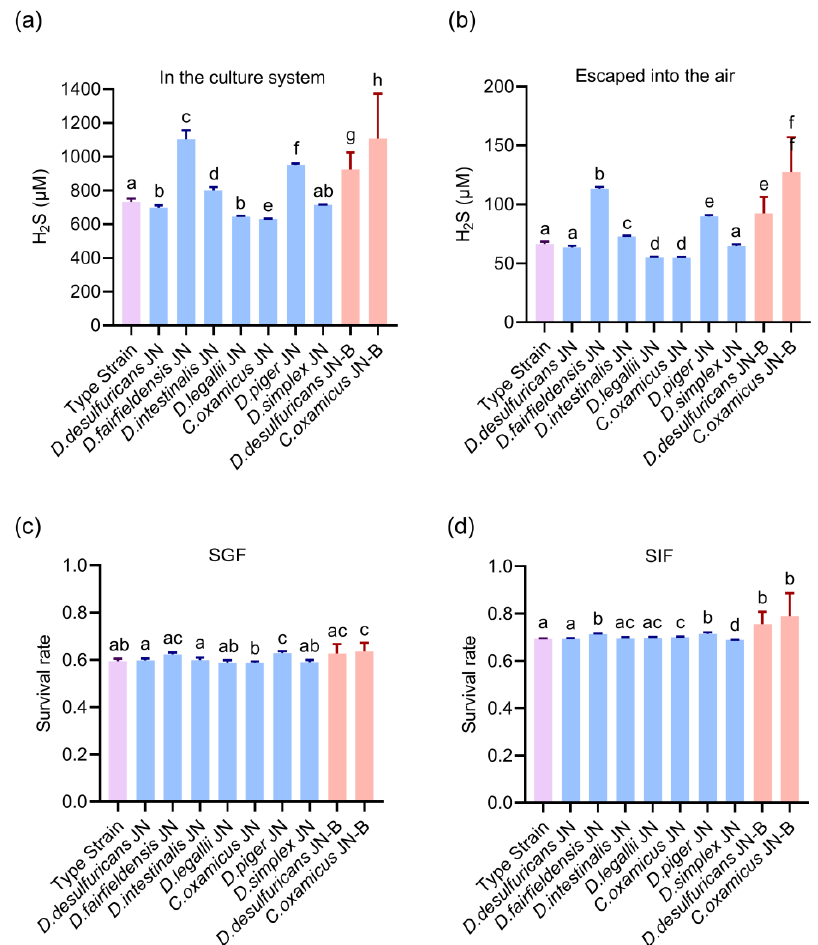
Figure 4. Hydrogen sulfide production and gastrointestinal tolerance of Desulfovibrio from the human gut. ( a , b ) The hydrogen sulfide production of isolates ( a ) in the culture system and ( b ) escaped into the air after 4 days of culture. ( c , d ) Evaluation of intestinal colonization of Desulfovibrio in ( c ) SGF (simulated gastric fluid) and ( d ) SIF (simulated intestinal fluid). The type strain was D. desulfuricans ATCC 29577. The blue bars were the strains from healthy volunteers, and the red bars were the stains from patients with liver cirrhosis, and the data are given as the means ± standard error of the mean (s.e.m.). Differences were identified using the t-test and One-way ANOVA statistical analysis, and different superscripts indicate significant differences ( p < 0.05). At the same time, the dissolving amount of H 2 S produced by D. desulfuricans JN-B from LC was significantly higher than that of the same strain from HV (Figure 4b). It was observed that the content of escaping H 2 S in Desulfovibrio derived from HV was the high- est in D. fairfieldensis JN and D. piger JN, which was significantly higher than that in the type strain, reaching 113.32 ± 1.29 μM and 89.77 ± 1.03 μM, respectively. Similar to the H 2 S content in the medium, D. legallii JN and C. oxamicus JN were also less than the control. The experimental results of LC showed that the H 2 S content of D. desulfuricans JN-B de- rived from LC was significantly higher than that of the standard strain, up to 87.82 ± 2.14 μM. Moreover, the proportion of H 2 S escape of all isolates was between 8.00%~10.00% (Figure 4b). The above results showed that the H 2 S production capacities of D. fairfieldensis and D. piger were the strongest compared with other Desulfovibrio species in this study, D. intestinalis was the second, and D. legallii and C. oxamicus were the weakest. These data